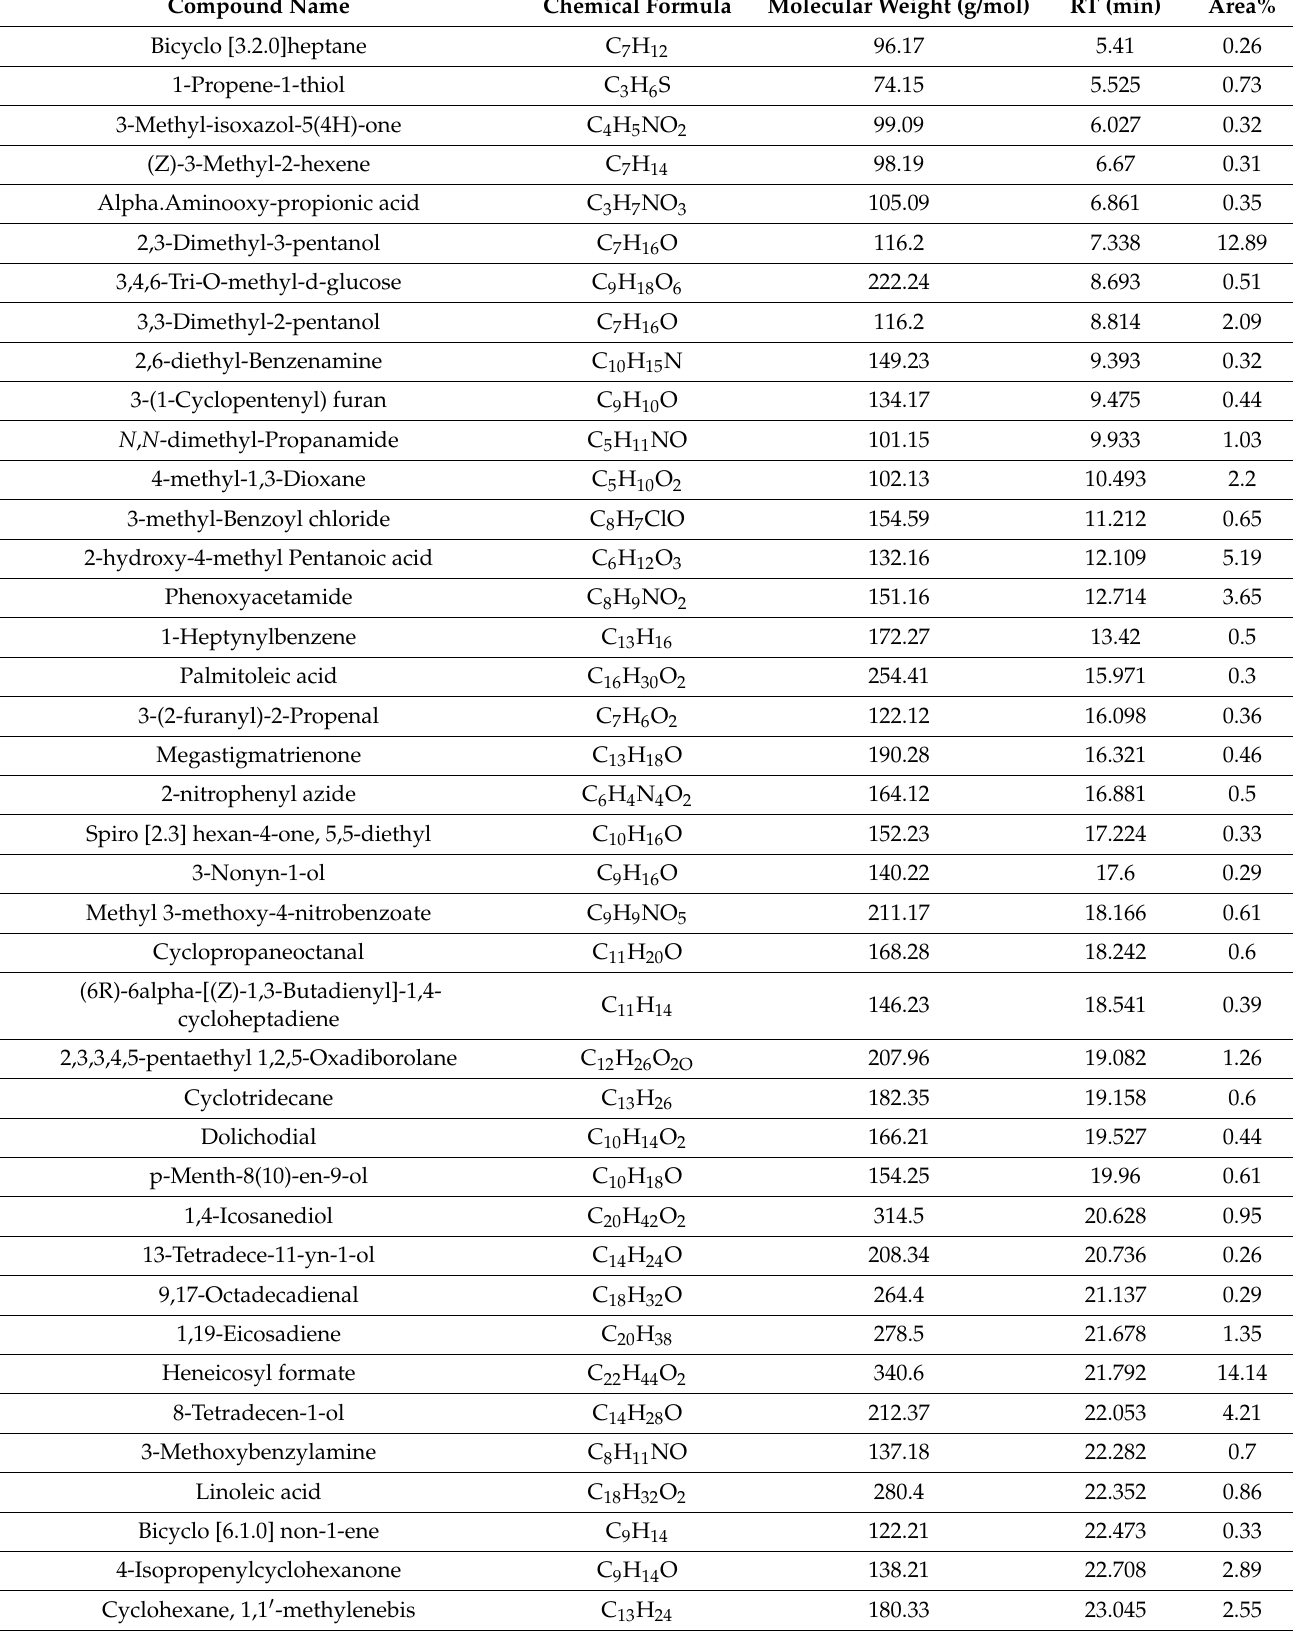
Table 3. The identified compounds from D. innoxia ethanolic extract by